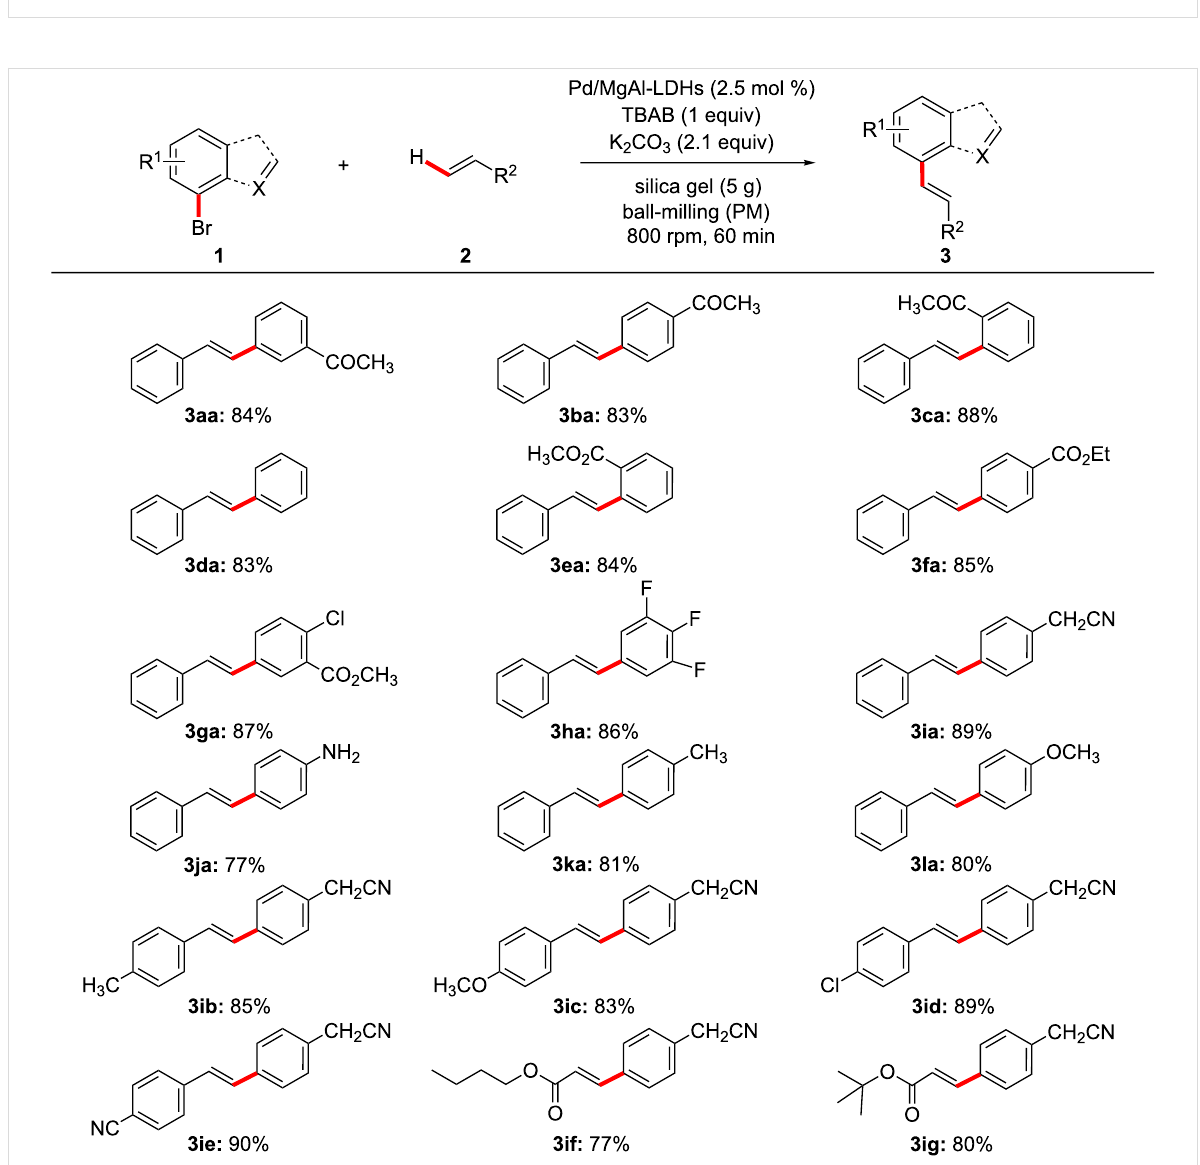
Figure 4: Substrate scope of Pd/MgAl-LDHs catalyzed Heck reactions. Reaction conditions unless otherwise noted: 1a (1.5 mmol), 2a (2.1 mmol), Pd/MgAl-LDHs (2.5 mol %), TBAB (1.5 mmol), K 2 CO 3 (3.6 mmol), and 5 g silica gel were placed in a 80 mL stainless-steel vessel ( Φ MB = 0.25, d MB = 5 mm). HSBM conditions: 60 min at 800